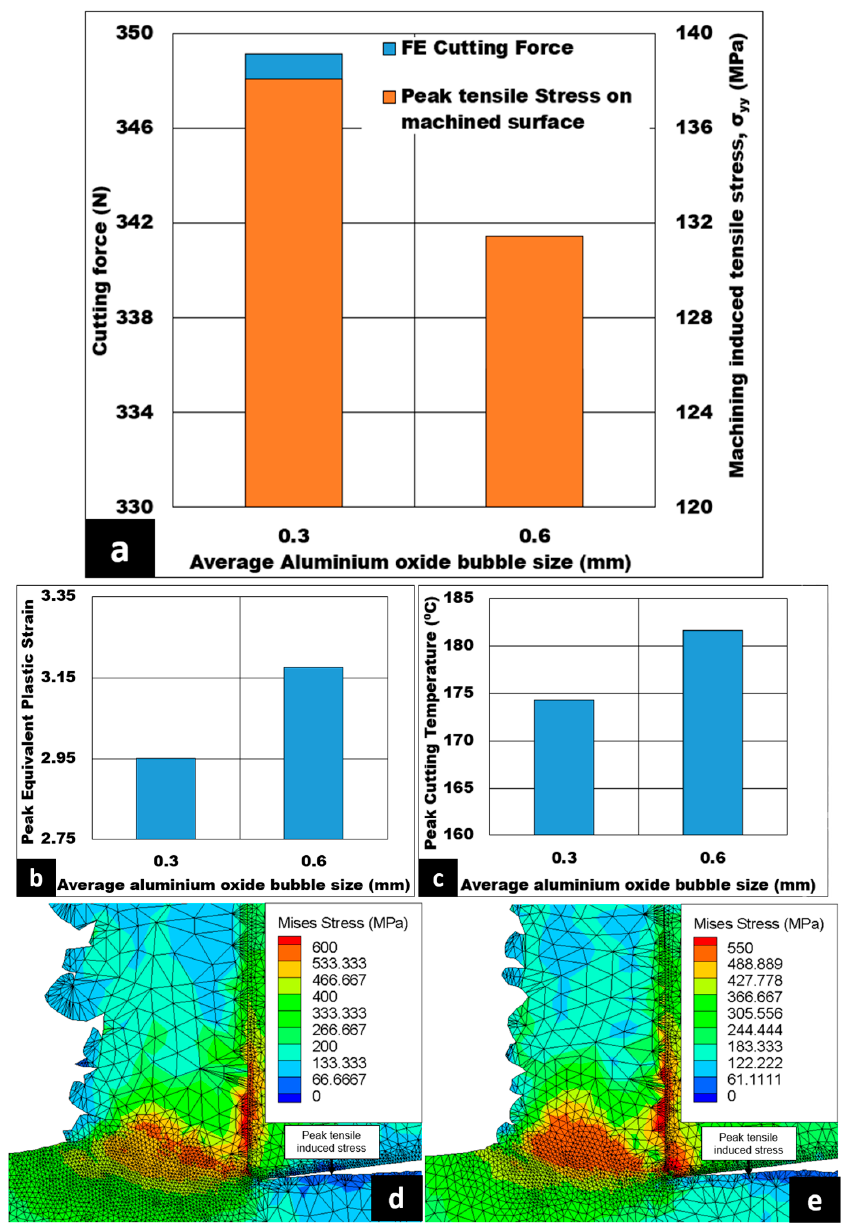
Figure 7. ( a – c ) Effect of average size of alumina bubble on cutting force, machining induced stress on machined surface, peak equivalent plastic strain, and peak cutting temperature (AdvantEdge TM simulation) under dry cutting. 7075/hollow alumina shell syntactic foams (Vc = 50 m/min, h = 0.07 mm, 10% volume fraction, b = 3 mm); Von Mises stress contour at ( d ) d = 0.3 mm and ( e ) d = 0.6 mm.